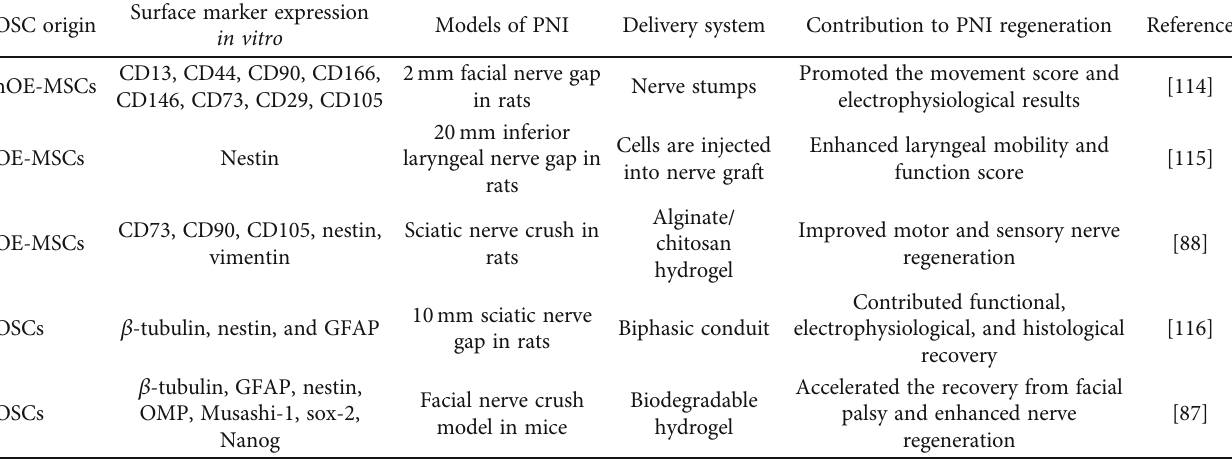
Table 3: E ff ect of OSCs in PNI animal